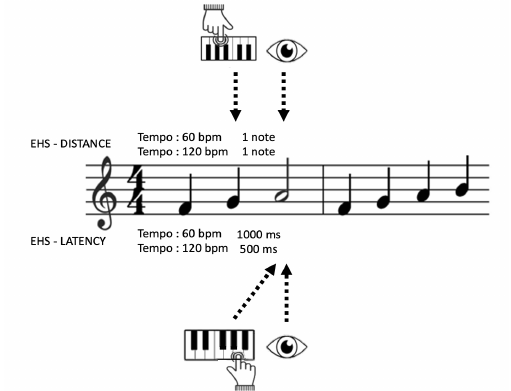
Figure 7. EHS measured in terms of both distance and laten- cy as a function of tempo.